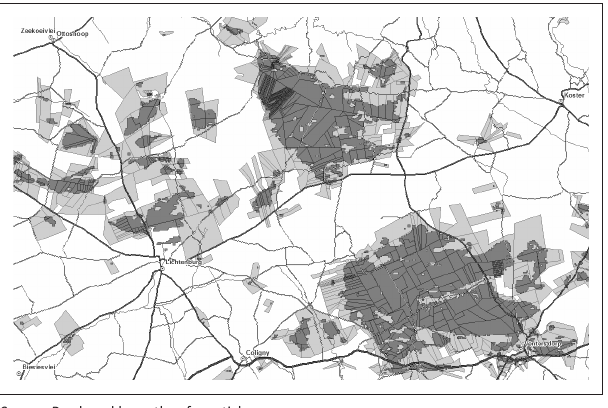
FIGURE 7: New dataset and map created from data values representing burn